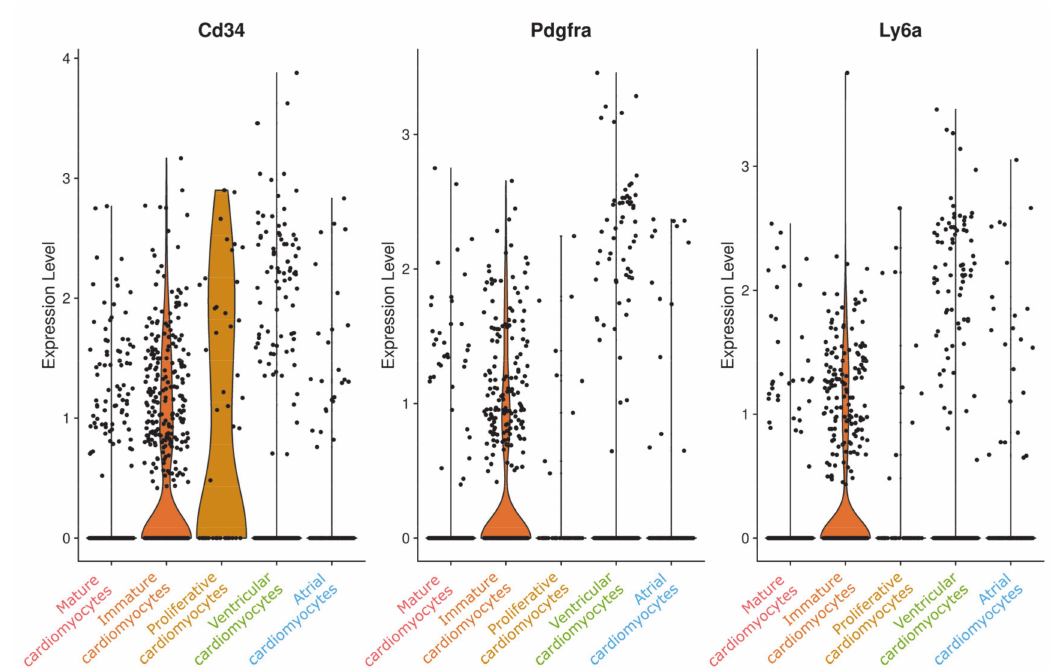
Figure 7. Violin plot of stem cell markers in the cardiomyocyte populations. Typical stem cell markers are expressed in low levels in immature cardiomyocytes, but not in “proliferative cardiomyocytes” except for Cd34, which showed moderate expression in several cell clusters of the integrated